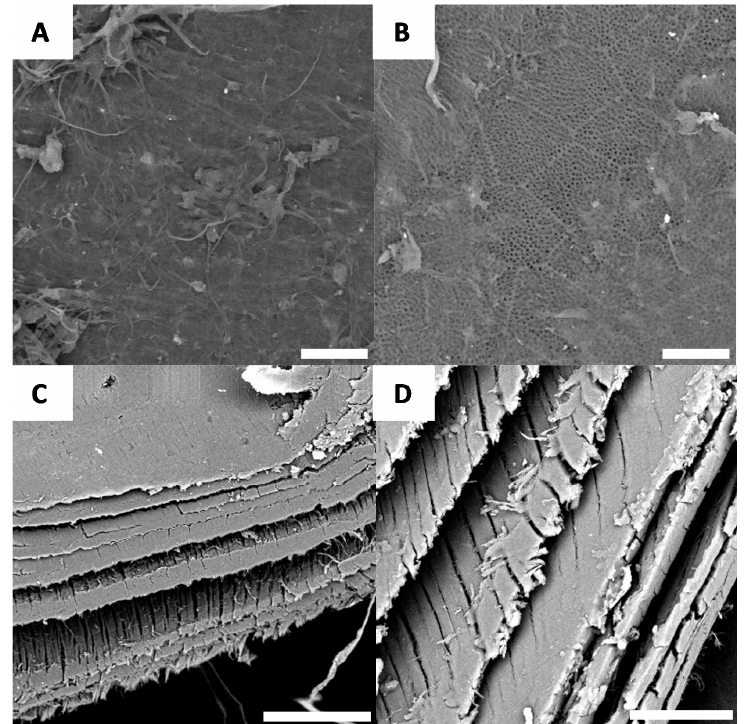
Figure 7. Examples of morphology observed for G. orientalis after bleaching ( A and B ) (Scale bar = 10 µm); Cross-section observations for G. orientalis after bleaching ( C and D ) (Scale bar = 80 µm). Biomimetics xxxx , x , x FOR PEER REVIEW After deacetylation, the entire surface is covered by a well-defined network (Figures 8A,B); after 220 deproteination and bleaching, the layer-by-layer structure of the chitin is preserved and can be 221 observed using cross-section microscopy (Figure 8C,D). 222